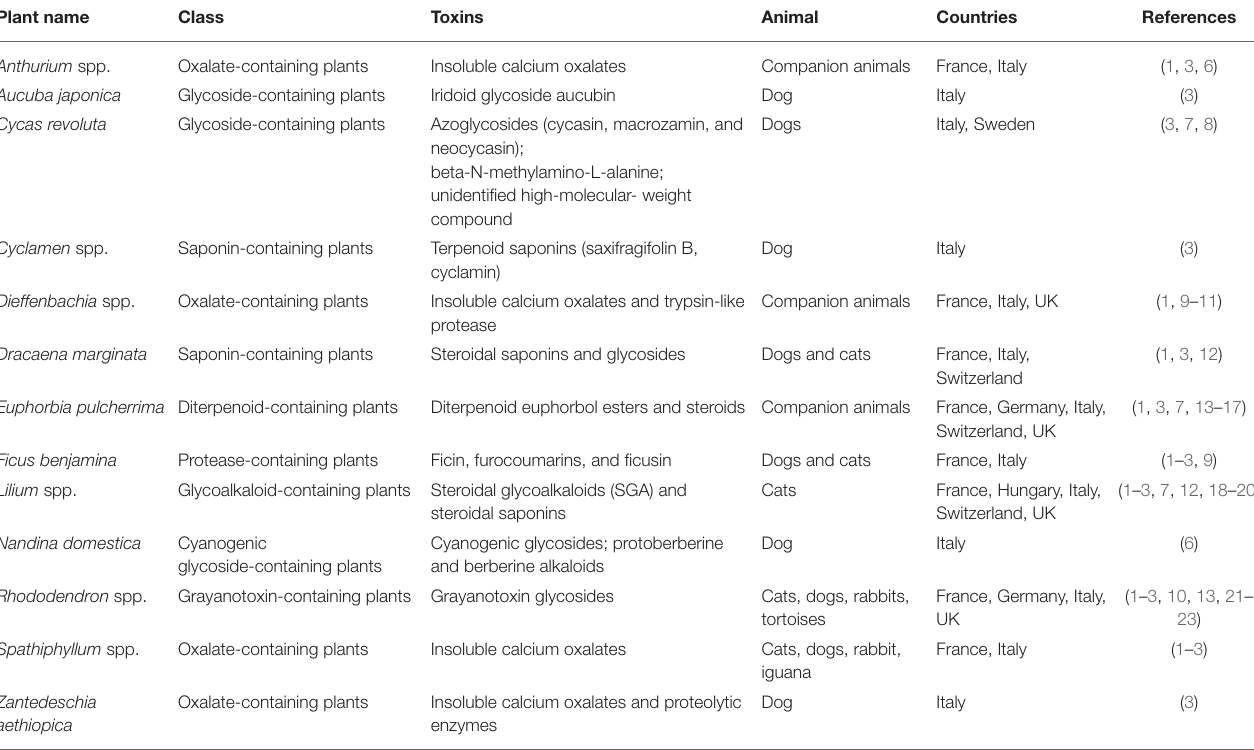
TABLE 1 | Toxic plants responsible for indoor poisoning of companion animals in